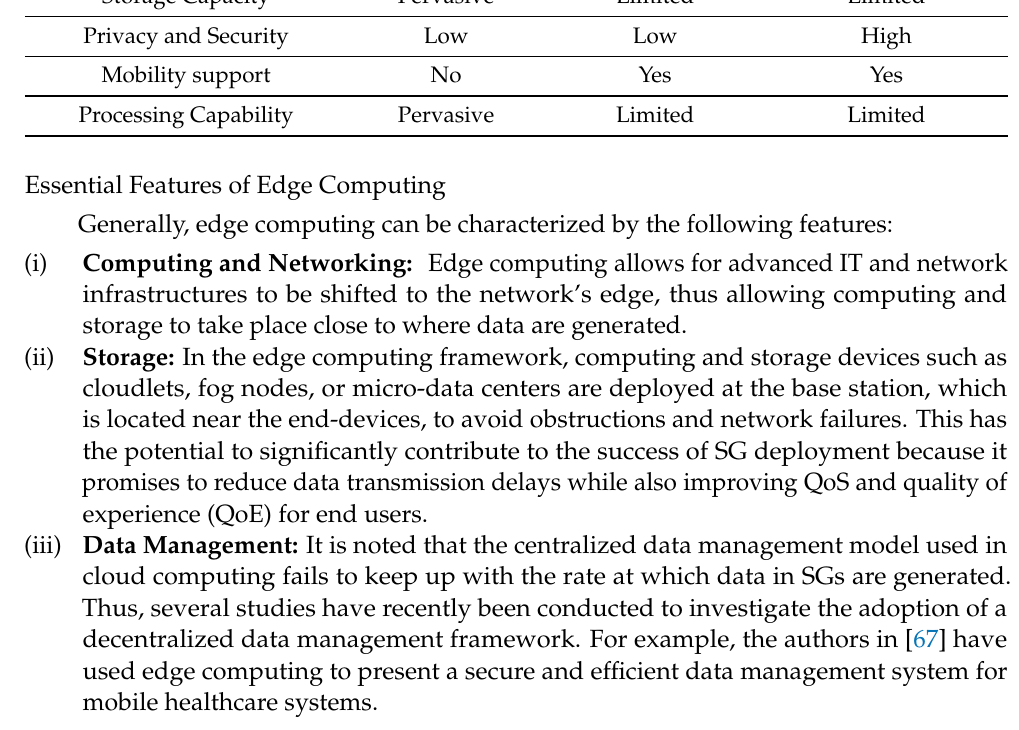
Table 2. Comparison of Cloud, Fog, and Edge Computing. Metrics Cloud Fog Edge Deployment Centralized Decentralized Decentralized Distance from end users Huge Small Extremely small Computational Power Pervasive Limited